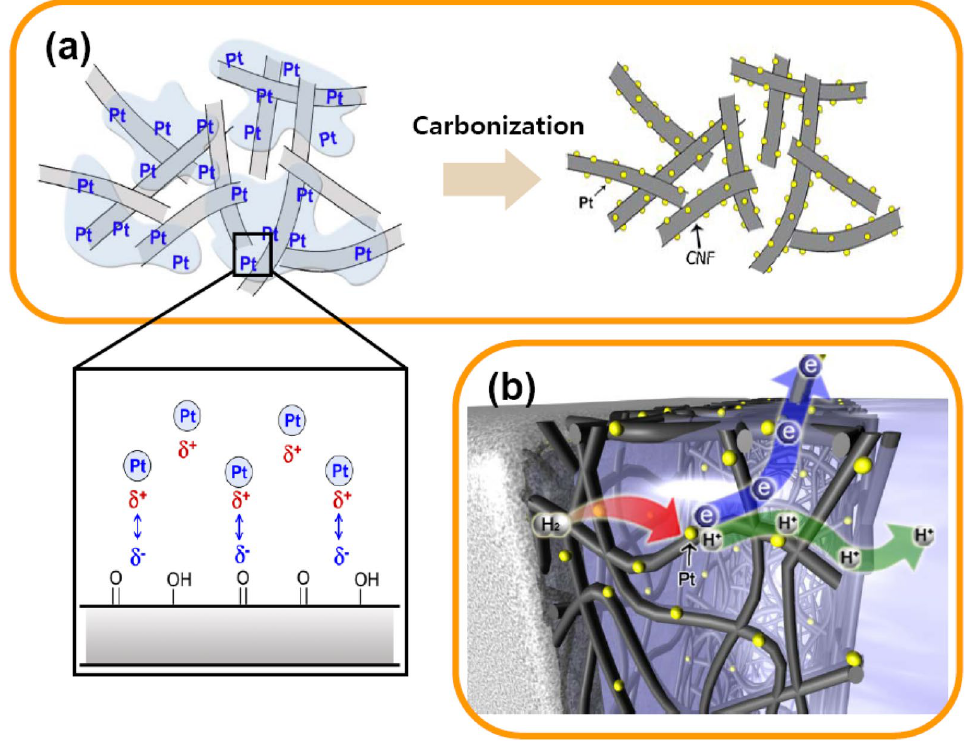
Figure 1. Schematic illustration of the HAS method. ( a ) Droplets of Pt(acac) 2 solution on the hydrolysed nanofiber paper and smearing of the droplets on the network of nanostructured nanofibers. Pt was adsorbed on the negatively charged (hydrolysed) nanofiber surface. ( b ) A schematic of the Pt-loaded nanofiber network and electrolytes forming a three-phase interface. Drawn by the 3D-Max program student